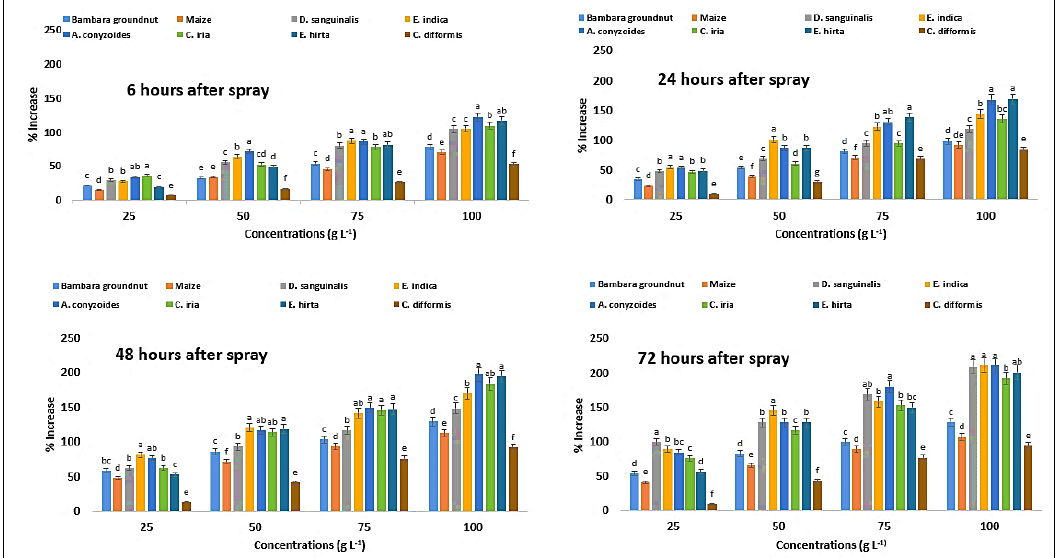
Figure 16. Increase (%) of peroxidase (POD) in several crops and weeds due to the foliar application of pathenium leaf methanol extract concentrations at the different associate times. Values with the same letter among the tested crops and parthenium weeds are not significantly different at the same extract concentrations at p ≤ 0.005 by Tukey ’ s HSD.